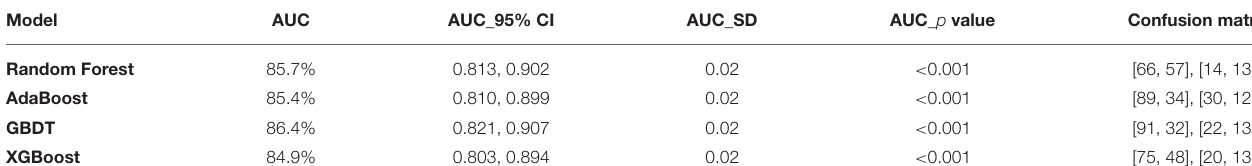
TABLE 4 | Performance of random forest, AdaBoost, GBDT, and XGBoost models to screen COVID-19.